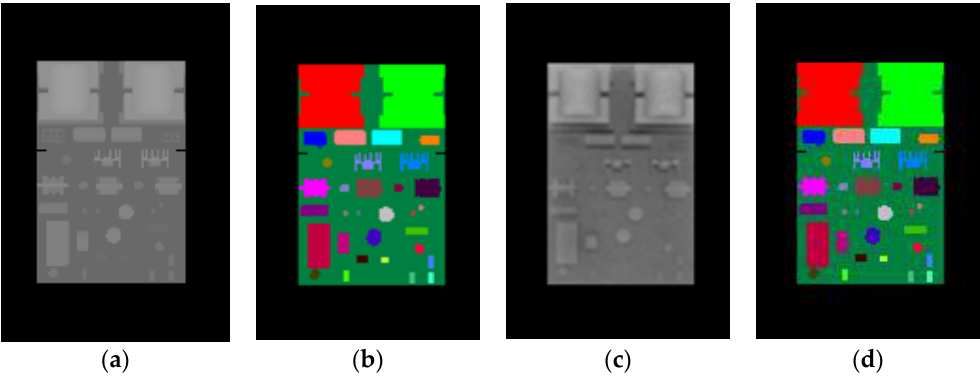
Figure 2. Depth images and corresponding color-labeled images of the printed circuit board (PCB). ( a ) Synthetic depth images. ( b ) Synthetic color-labeled images. ( c ) Real depth images. ( d ) Real images labeled with colors.